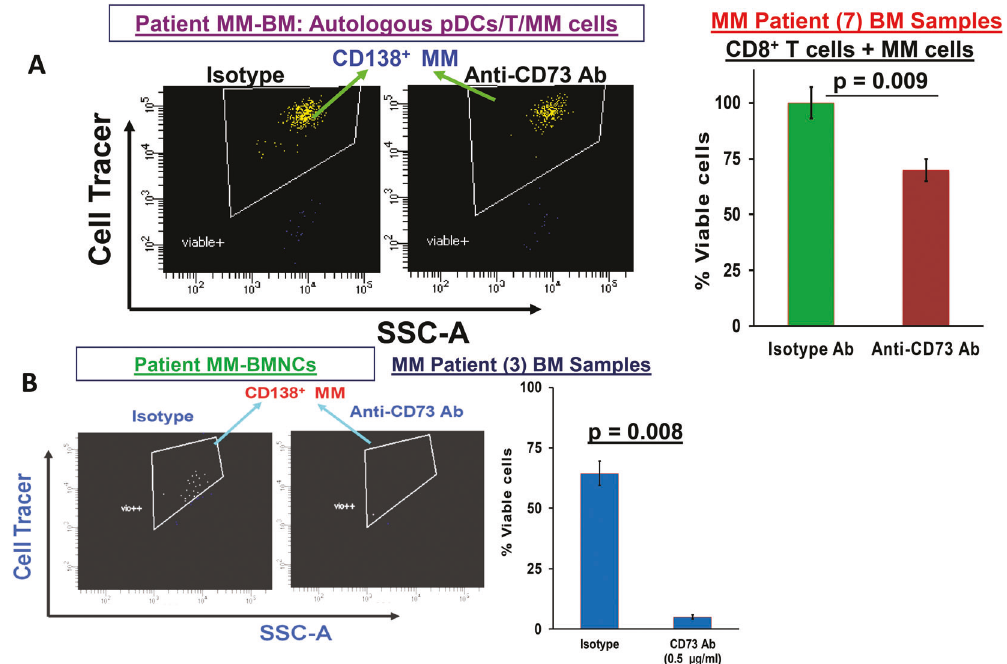
Fig. 5 Blockade of CD73 induces T cell-mediated autologous MM cell killing. A MM patient ( n = 7) BM CD8 + T cells were co-cultured with autologous pDCs (1pDC: 10 T cells), in the presence or absence of anti-CD73 Ab (0.5 µg/ml) for 3 days. After washing to remove anti-CD73 Ab, cells were cultured for 24 h with autologous MM (CD138 + ) cells pre-stained with CellTracker Violet (T/MM; 10:1 ratio), followed by 7-AAD staining, and quanti fi cation of CTL-mediated MM cell lysis by FACS. The 7-AAD + populations were gated out and viable 7-AAD negative cells were further gated to quantify 7-AAD negative CellTracker Violet + cells. Left panel: representative FACS scatter plot showing the decrease in the number of viable 7-AAD negative/Cell Tracker-positive MM cells. Right panel: bar graph shows quanti fi cation of CD8 + CTL-mediated MM cell lysis, re fl ected in decreased CD138 + MM cell viability after anti-CD73 Ab treatment, using data obtained in left panel (mean ± SD; p < 0.05). B MM patient ( n = 3) total BM-MNCs were treated with anti-CD73 Ab (0.5 µg/ml) or isotype-Ab for 2 days, and multicolor fl ow analysis was utilized to assess MM cell lysis. CD138 + MM cells were quanti fi ed by staining with CD138-FITC Ab. Left panel : representative FACS scatter plot showing a decrease in number of viable FITC-positive MM cells after anti-CD73 Ab treatment. Right panel : bar graph shows quanti fi cation of CD138 + MM cells in left panel. The fold change was obtained after normalization with control data, and presented as a percentage of viable cells in the presence versus absence of anti-CD73 Ab (mean ± SD; p < determined whether CD73 blockade restores pDC immune function and triggering of immune effector cells. As shown in Fig. 4A – D, treatment of MM patient pDCs with anti-CD73 Ab activates pDCs, evidenced increased expression of maturation/ activation markers (CD40/CD83/CD86/HLA-DR). Importantly, treat- ment of MM patient pDCs with anti-CD73 Ab restores their ability (Fig. 3C). Conversely, blockade of CD73 using anti-CD73 Ab to trigger the activation of autologous T cells (Fig. 4E; mean ± SD; signi fi cantly reduced (~18%) adenosine levels in pDC-MM co- n = 3, p < 0.05). cultures in a concentration-dependent manner (Fig. 3C; p = 0.0167). Blockade of CD73 triggers pDC-mediated T cell-cytolytic activity against MM cells We have previously shown that activation of pDCs upon treatment with immunomodulatory agents can stimulate T cell immune function in MM [5 – 10, 12]. We therefore next further examined whether anti-CD73 Ab-activated pDCs can trigger cytotoxic T lymphocyte (CTL) activity. These studies were carried out using co-